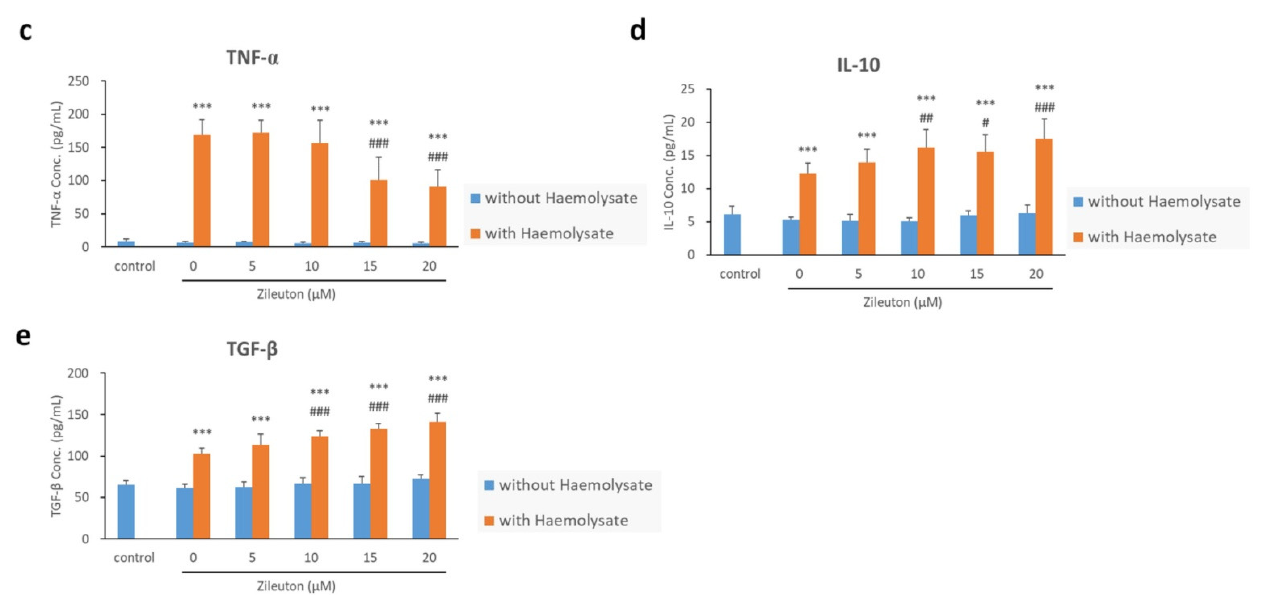
Figure 5. ELISA results for LTB4, IL-1 β , TNF- α , IL-10, and TGF- β from the cell culture supernatant. ( a ) ELISA results for LTB4. The concentration of LTB4 in the haemolysate + vehicle group was higher than that in the control group. Following treatment with 5, 10, 15, and 20 µ M of zileuton, the haemolysate-exposed BV-2 cells showed a lower concentration of LTB4 than those treated with the vehicle. There was no significant difference between haemolysate-exposed, zileuton-treated BV-2 cells, and BV-2 cells in the control group (*** p < 0.001 compared with control; ## p < 0.01, ### p < 0.001 compared with haemolysate + vehicle group, n = 3). ( b ) ELISA results for IL-1 β . The haemolysate + vehicle group and the haemolysate + zileuton (5, 10, 15, and 20 µ M) groups had a higher concentration of IL-1 β than the control group. The haemolysate-exposed BV-2 cells treated with 10, 15, and 20 μΜ of zileuton displayed a lower concentration of IL-1 β than BV-2 cells in the haemolysate + vehicle group (*** p < 0.001 compared with control; # p < 0.05, ### p < 0.001 compared with haemolysate + vehicle group, n = 3). ( c ) ELISA results for TNF- α . The haemolysate-exposed BV-2 cells treated with the vehicle, as well as 5, 10, 15, and 20 μΜ of zileuton, showed elevated concentrations of TNF- α compared with the control group. The haemolysate-exposed BV-2 cells treated with 15 and 20 μΜ of zileuton showed a lower concentration of TNF- α than those treated with the vehicle (*** p < 0.001 compared with control; ### p < 0.001 compared with haemolysate + vehicle group, n = 3). ( d ) ELISA results for IL-10. The haemolysate-exposed BV-2 cells treated with the vehicle, as well as 5, 10, 15, and 20 μΜ of zileuton, had an increased concentration of IL-10 compared with the control group. After being treated with 10, 15, and 20 μΜ of zileuton, haemolysate-exposed BV-2 cells showed a higher concentration of IL-10 than those treated with the vehicle (*** p < 0.001 compared with control; # p < 0.05, ## p < 0.01, ### p < 0.001 compared with haemolysate + vehicle group, n = 3). ( e ) ELISA results for TGF- β . The haemolysate-exposed BV-2 cells treated with the vehicle, as well as 5, 10, 15, and 20 μΜ of zileuton, showed an elevated concentration of TGF- β compared with the control group. Additionally, the concentration of TGF- β was higher in the haemolysate-exposed BV-2 cells treated with 10, 15, and 20 of zileuton than in those treated with the vehicle (*** p < 0.001 compared with control; ### p < 0.001 compared with haemolysate + vehicle group, n = 3).